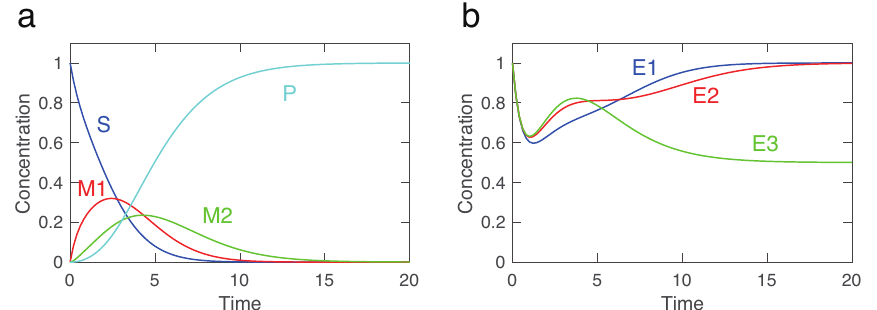
Figure 5. Simulation of the created SBML model for the three-step model. ( a ) S, M1, M2, and P represent the substrate, first intermediate metabolite, second intermediate metabolite, and product, respectively. ( b ) E1, E2, and E3 represent the first, second, and third enzymes, respectively. This model was created by KinModGPT with text-davinci-003